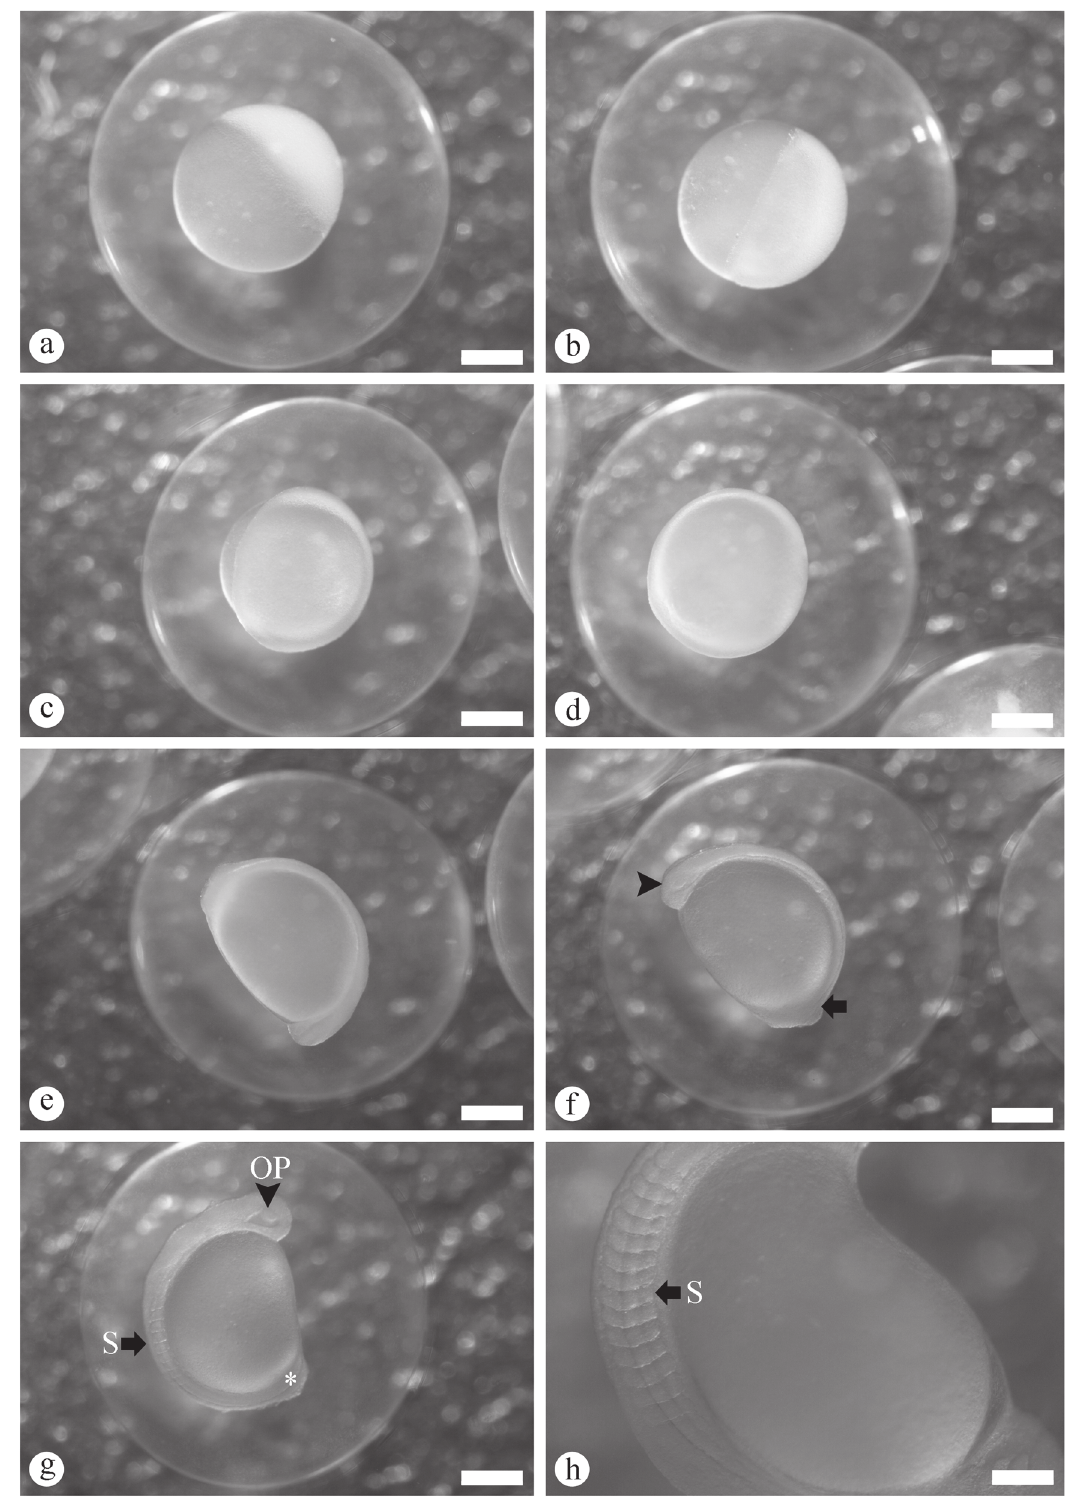
Fig. 3. Macroscopic aspects of embryonic and larval development of Steindachneridion parahybae . a-c ) gastrula stage: a ) epiboly of 25%; b ) epiboly of 50%; c ) epiboly of 90%; d ) final gastrula stage and blastopore closure (11 h 20 min AF); e-h ) organogenesis stage: e ) organogenesis and embryo growth (beginning of differentiation of embryonic layer); f ) differentiation of embryonic layers, head (arrowhead) and tail (arrow) (14 h 25 min AF); g ) distinguish between the cephalic (arrowhead) and caudal (asterisk) regions, somites (S), and optic vesicle (OP); h ) Detail of somites development (S). Bars: (a-g) 0.3 mm; (h) 0.2